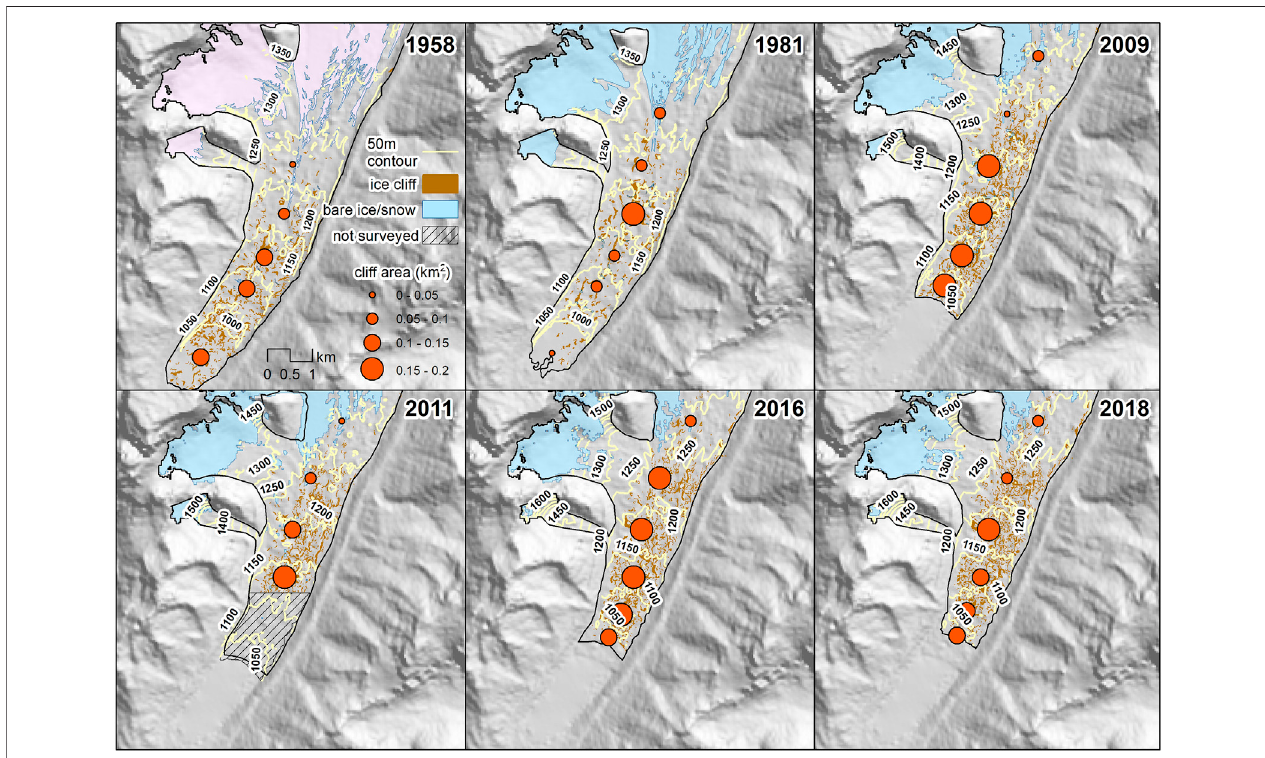
FIGURE 6 | Ice cliff and pond distribution and temporal evolution in the San Lorenzo Sur